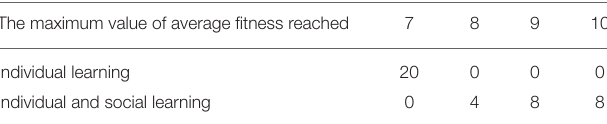
TABLE 4 | Breakdown of the how much average fitness increased (Total